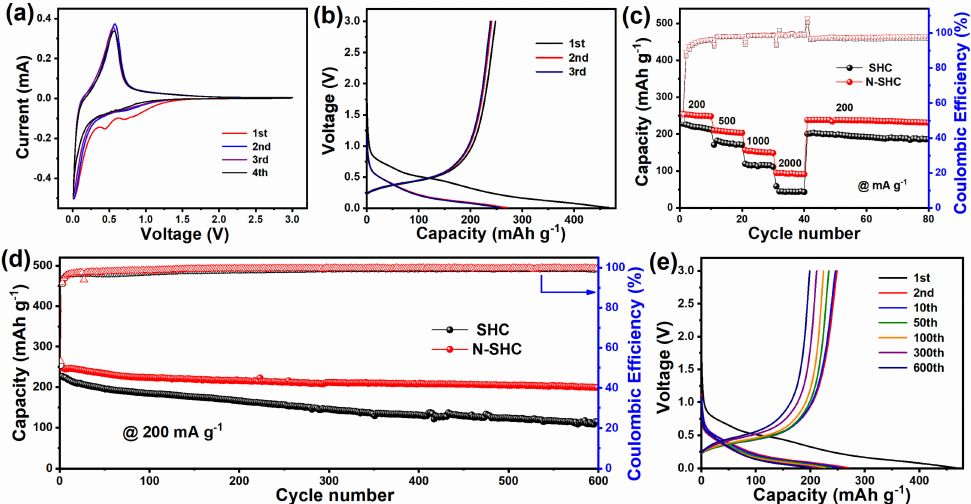
Figure 2. ( a ) CV curves and ( b ) charge-discharge profiles of the N-SHC electrode. Compared ( c ) rate performance and ( d ) long-term cycle properties at 200 mA g − 1 for N-SHC and SHC electrodes. ( e ) Corresponding charge-discharge profiles of N-SHC at 200 mA g − 1 after various